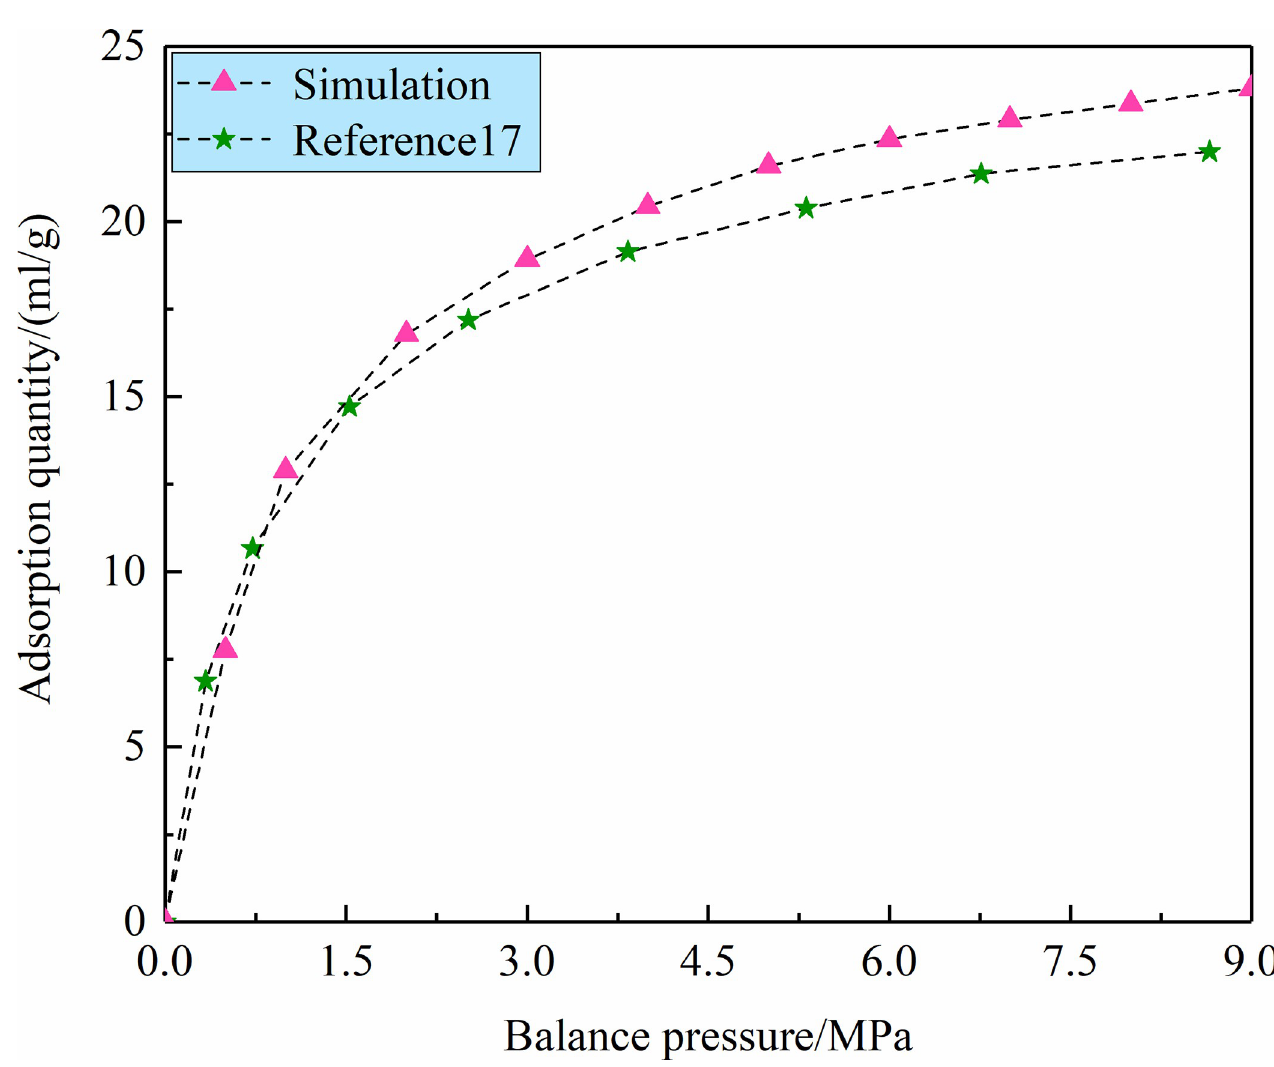
Fig 13. Comparison of CH4 adsorption simulation and